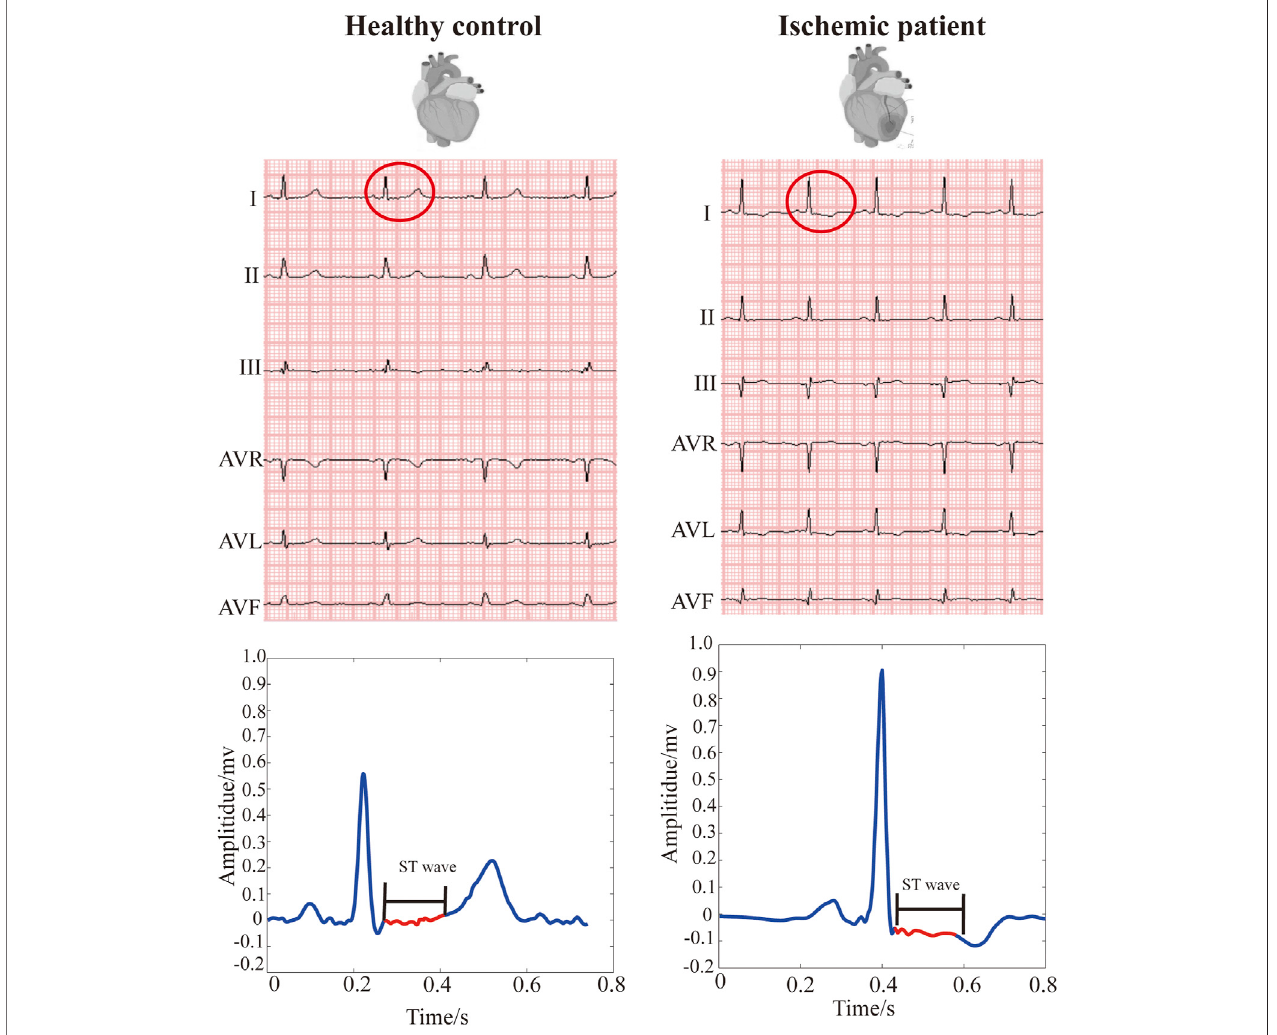
FIGURE1| Ischemia-relatedchangesinST-wave(ST-segment). (A) STwavefromahealthycontrol. (B) STwavefromapatientwithmyocardialischemia.Redline presents ST wave in ECG.